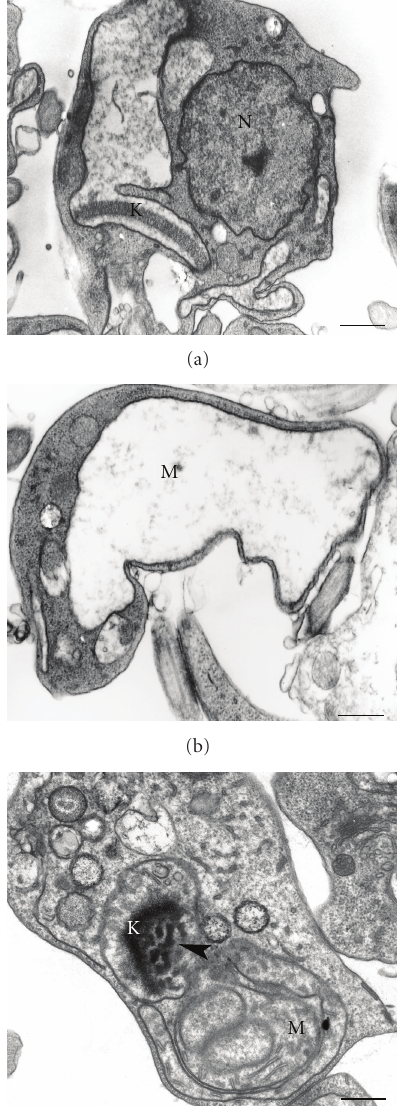
Figure 6: Trypanosoma cruzi epimastigotes treated with keto- conazole, an inhibitor of the C14 α -demetilase (a)-(b), and L. amazonensis promastigotes treated with E5700, an inhibitor of the squalene synthase (c) showing an intense mitochondrial swelling (a)-(b) and alterations in the kinetoplast structure ((c), arrowhead ). K, kinetoplast; M, mitochondrion. (a)-(b) Images are reproduced with permission from [74] American Society for Microbiology. Bars, 0 . 5 μ m.